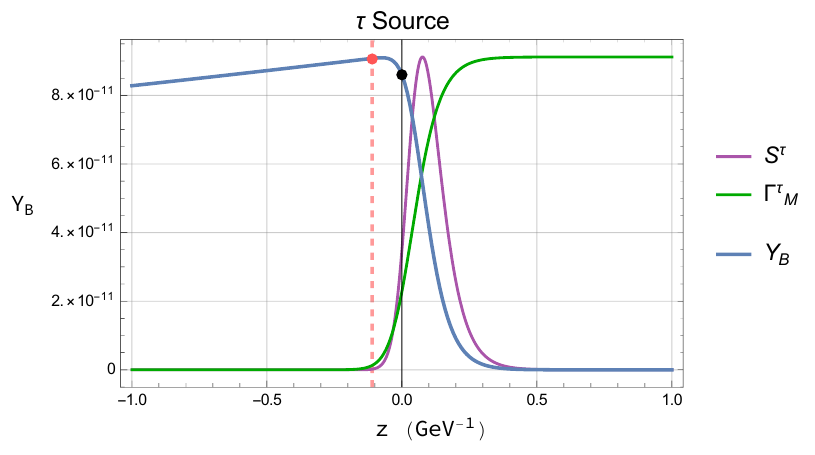
Figure 5. Y B with a tau source as a function of the position of the bubble wall. The blue line is Y B ; the purple line is the source shape, arbitrarily normalized to fit plot scale; the green line is the relaxation rate, similarly normalized; and the dashed red line is the shift by the thickness of the bubble wall to z = − L w = − 0 . 11 GeV − 1 . The black dot is the predicted Y B placing the wall at z = 0 , and the red dot the predicted value Y B = 9 × 10 − 11 placing the wall at z = − L w